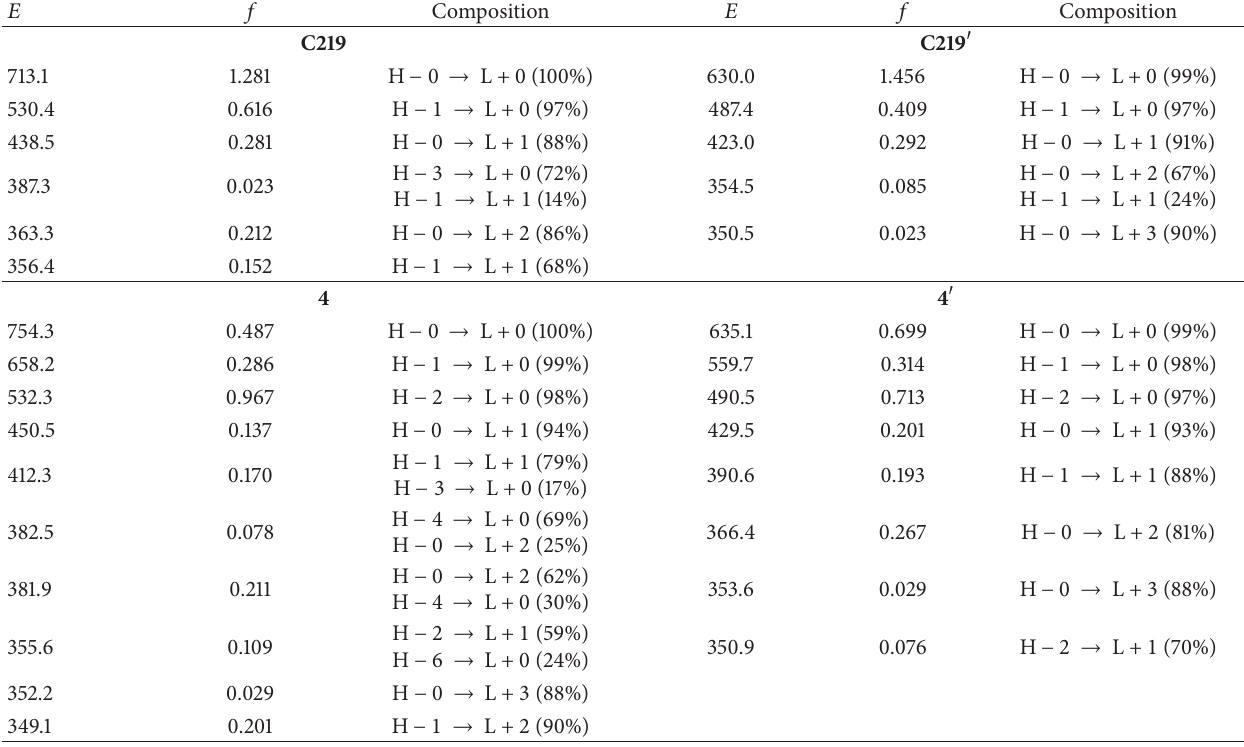
Table 1: Selected excitation energies ( 𝐸 , nm), oscillator strength ( 𝑓 ), and relative orbital contributions to the optical transitions between 350 and 800nm of the absorption spectra of tpa-based sensitizers in chloroform solution a . 𝐸